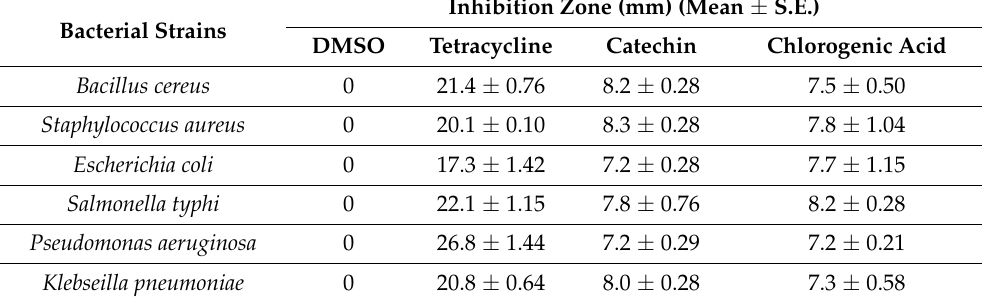
Table 1. Antibacterial activity of tetracycline, catechin, and chlorogenic acid against the tested path- ogenic bacterial strains.